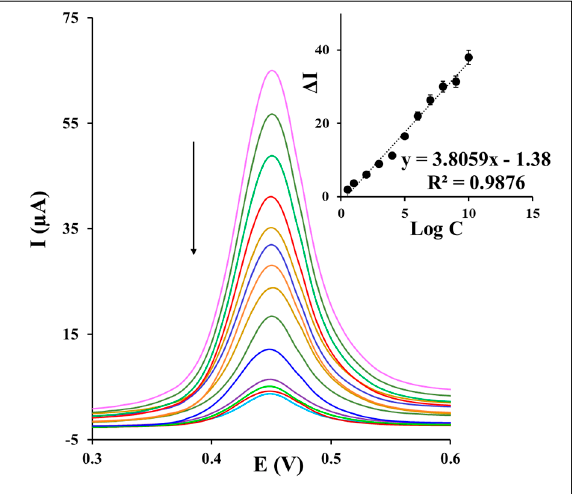
Figure 5. The DPVs of the aptasensor and inset a corresponding calibration curve after incubation with a series of different concentrations of S. aureus from 10 CFU mL − 1 to 10 8 CFU mL − 1 during an incubation time of 30 min in 0.1 M PBS containing 0.1 M KCl and 1 mM [ Fe ( CN ) redox